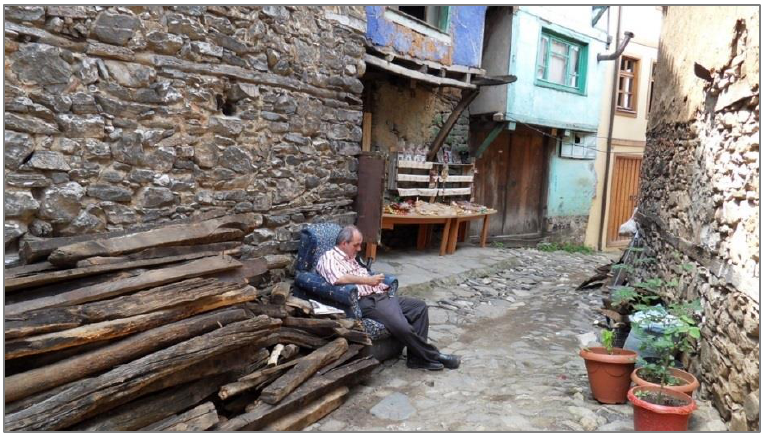
Figure 19 The Dialogue of Culture and Environment in Cumalıkızık